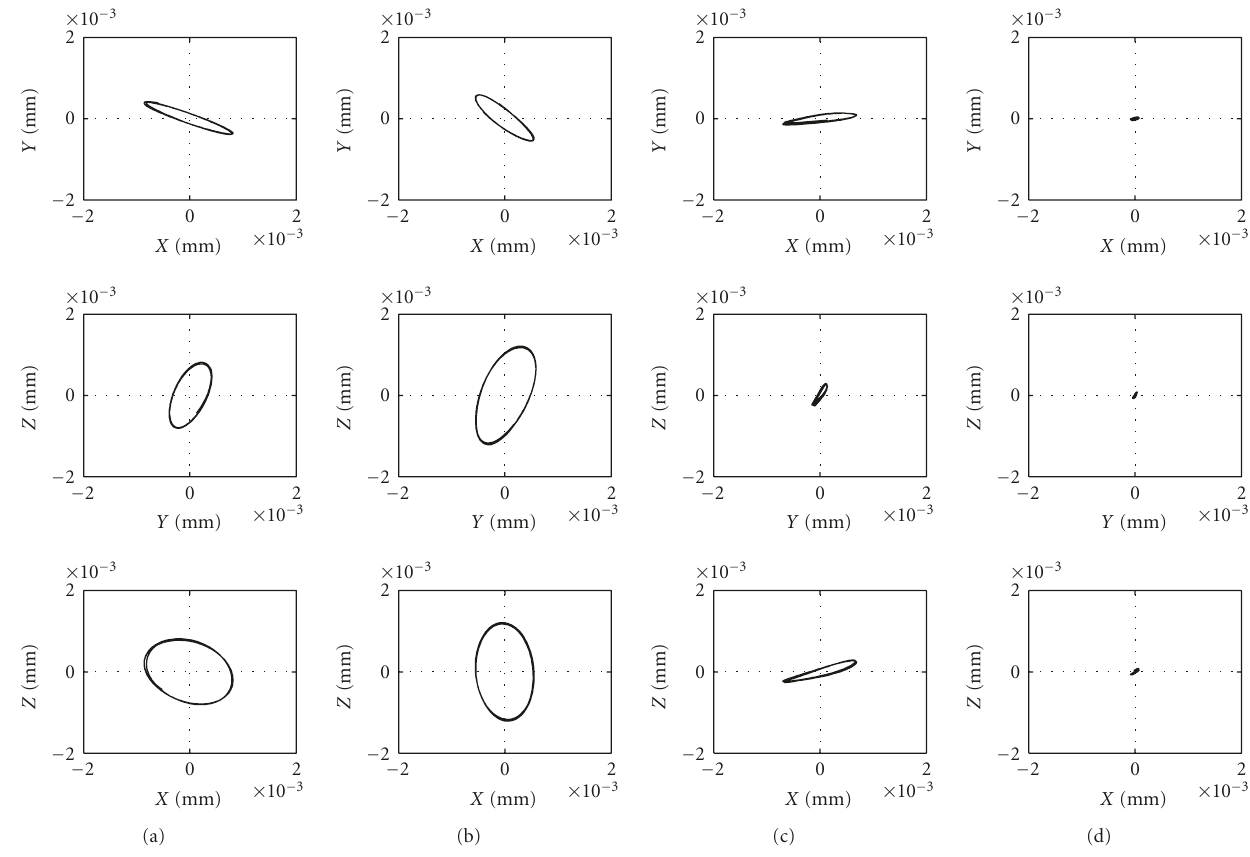
Figure 6: An example of the BF muscle belly trajectories over the ( x , y ), ( y , z ) and ( x , z ) planes, at di ff erent stimulation frequencies ((a) = 16Hz, (b) = 25 Hz, (c) = 40Hz, (d) = 50 Hz). The figure corresponds to P1 subject positioning.